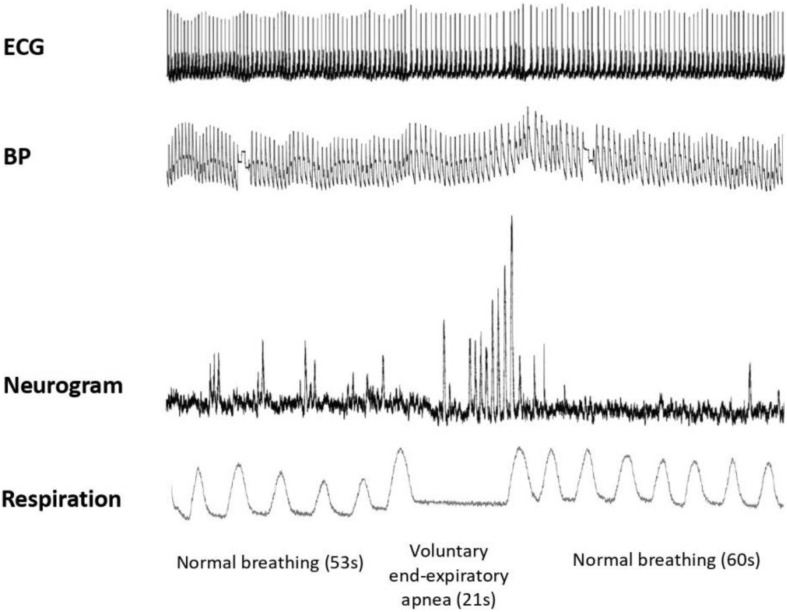
MSNA variations during baseline and voluntary end-expiratory apnea. Normal respiration during baseline (53 s length), maximal voluntary end-expiratory apnea (21 s length), and normal respiration during recovery (60 s) are illustrated. From top to bottom: ECG; blood pressure (BP); neurogram and respiration. Toward the end of the apnea, a marked rise in the sympathetic nerve activity is observed, characterized by increased number of bursts with higher amplitude.